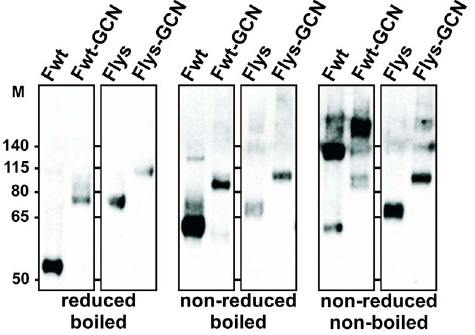
Figure 2. Western blot analysis of recombinant F proteins. Purified F proteins (Fwt, Fwt-GCN, Flys and Flys-GCN) were analyzed by SDS-PAGE followed by Western blotting. Fwt-GCN and Flys-GCN contain a C-terminal LysM domain and ST3 tag. Fwt and Flys contain a C- terminal ST3 tag. The presence (reduced) or absence (non-reduced) of 2-mercaptoethanol in the sample buffer and boiling of the samples prior to electrophoresis is indicated. F proteins were detected using Palivizumab. The size of the molecular mass markers (in kDa) is shown on the left (M), while position of the markers in the gels is indicated.